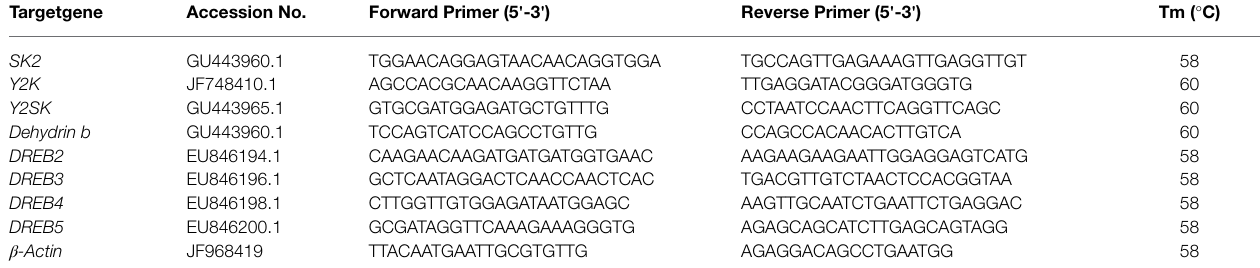
TABLE 1 | Primer sequences and corresponding GeneBank accession numbers of the analyzed genes. Targetgene